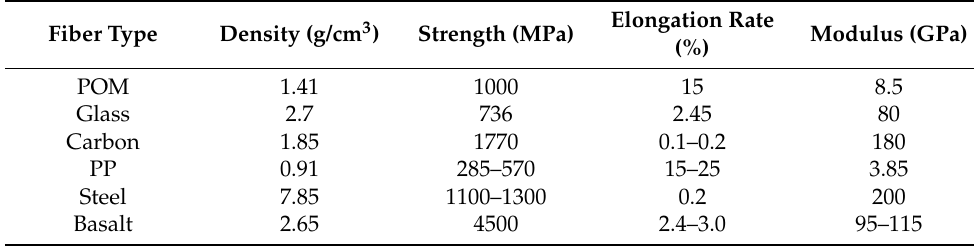
Table 1. Comparison of fiber